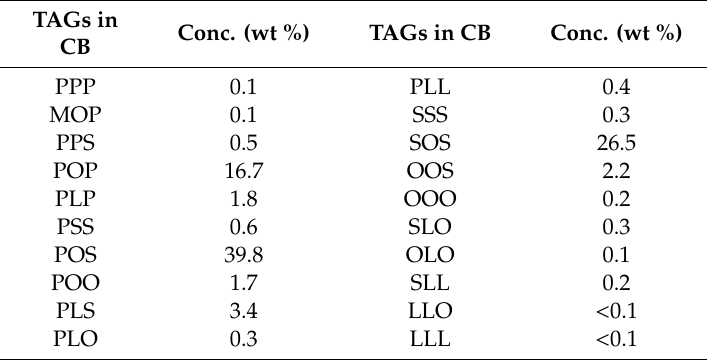
Table 2. TAG composition of